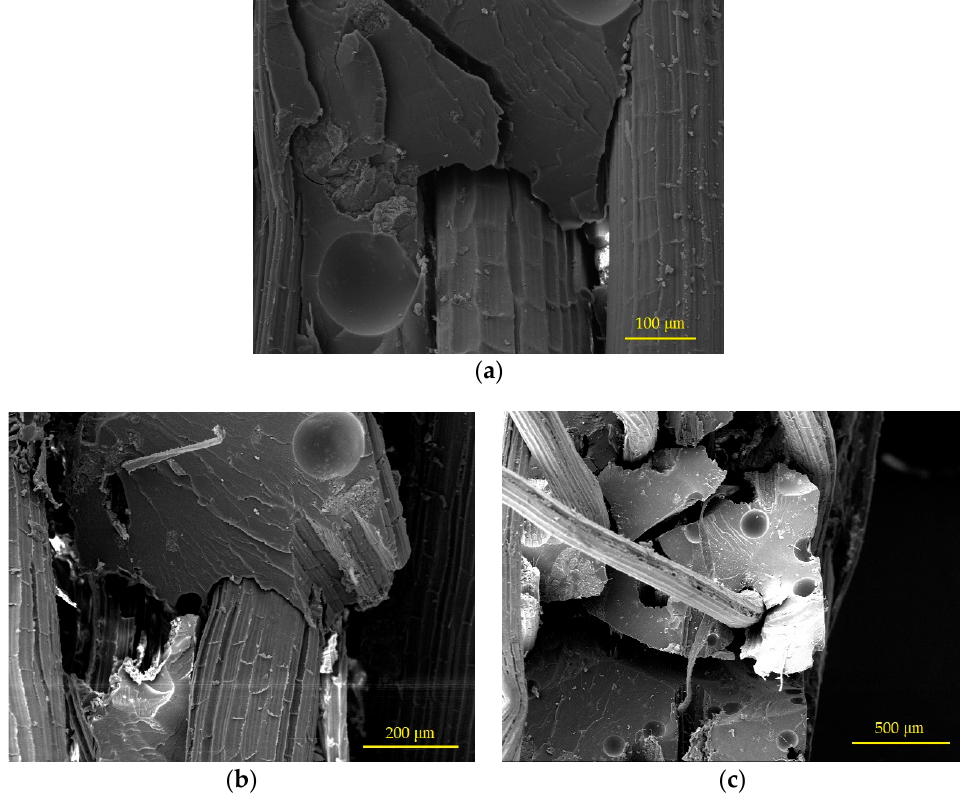
Figure 8. Micrographs of composites polymer/fiber/5% bentonite: ( a ) an amount of 15% fiber, bar corresponds to 100 μ m; ( b ) 20% fiber, bar corresponds to 200 μ m; and ( c ) 25% fiber, bar corresponds to 500 μ m.